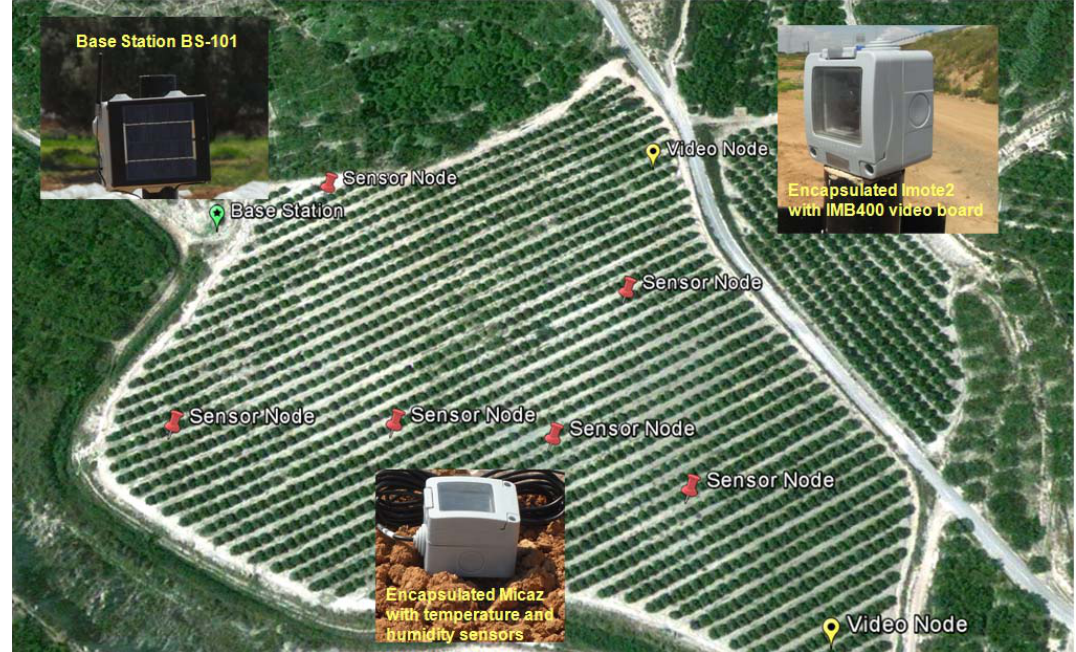
Figure 5. Test-bed/Trial scenario in Campo de Cartagena (Spain). Real devices are exactly deployed as indicated by the design